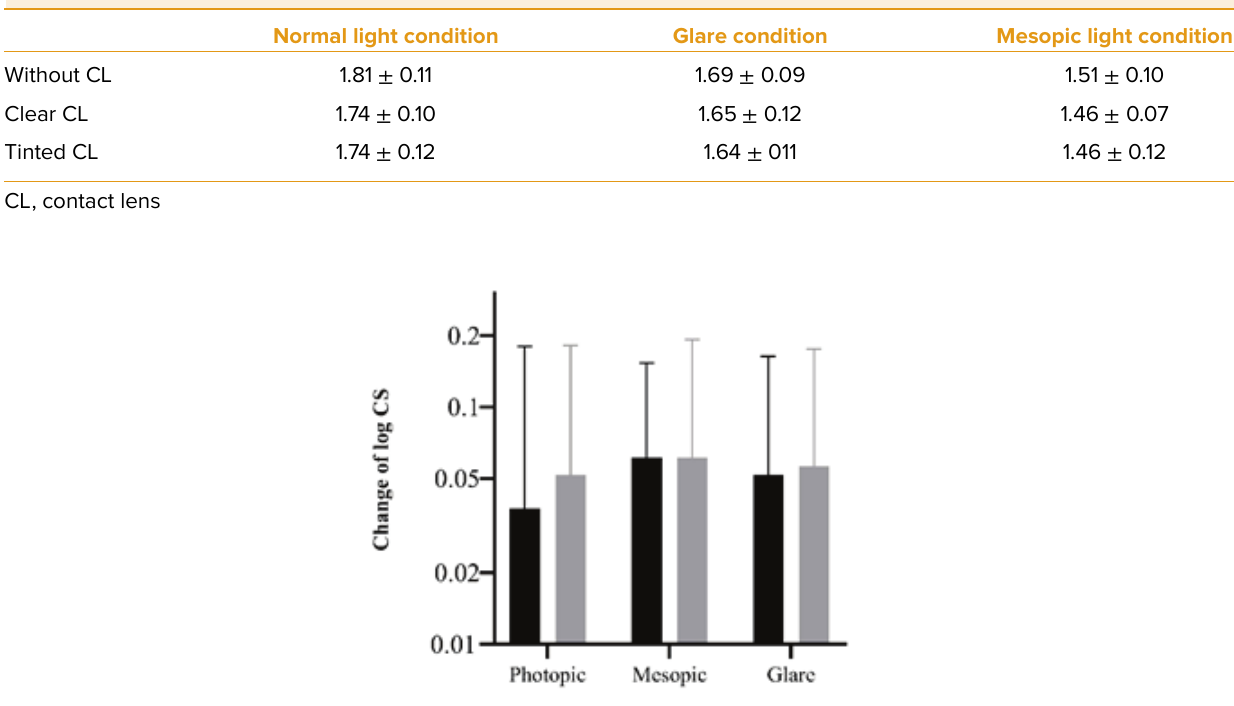
Table 1. Mean and standard deviation of log contrast sensitivity under different lighting conditions in clear and colored contact